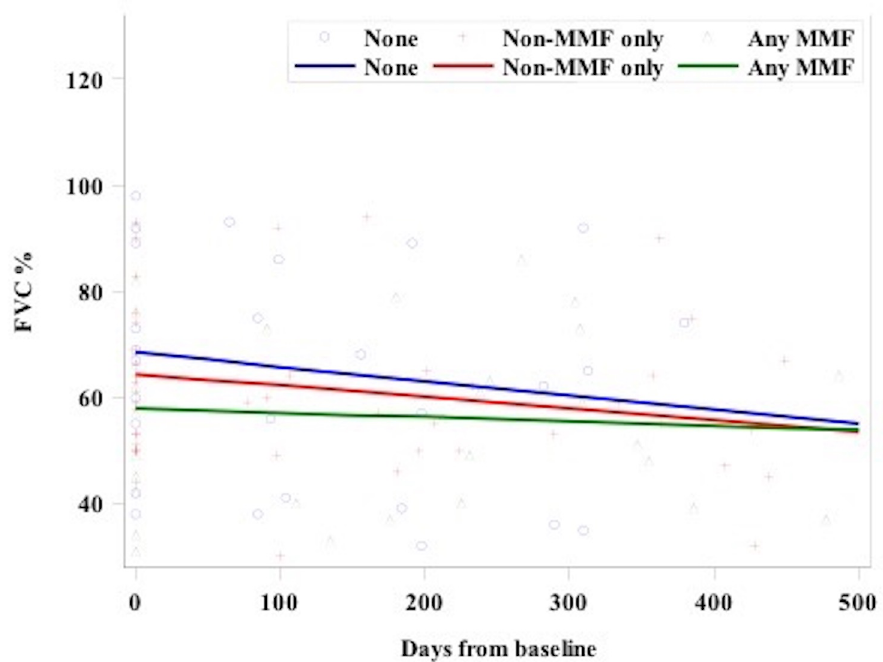
Fig 1. Change in FVC from baseline to 12 months. p-valuefor days by treatment group interaction = NS using a mixed model with random intercept and slope.